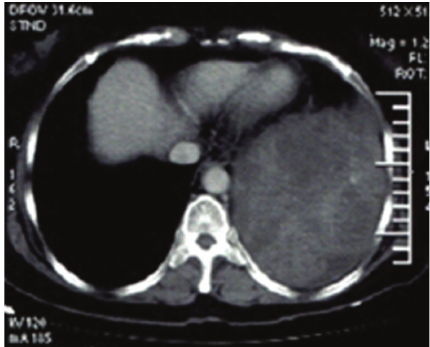
Figure 1: CT findings of angiosarcoma of the diaphragm (tumors were located under the chest, a huge volume, heterogeneous en- hancement, No mediastinal lymph nodes).